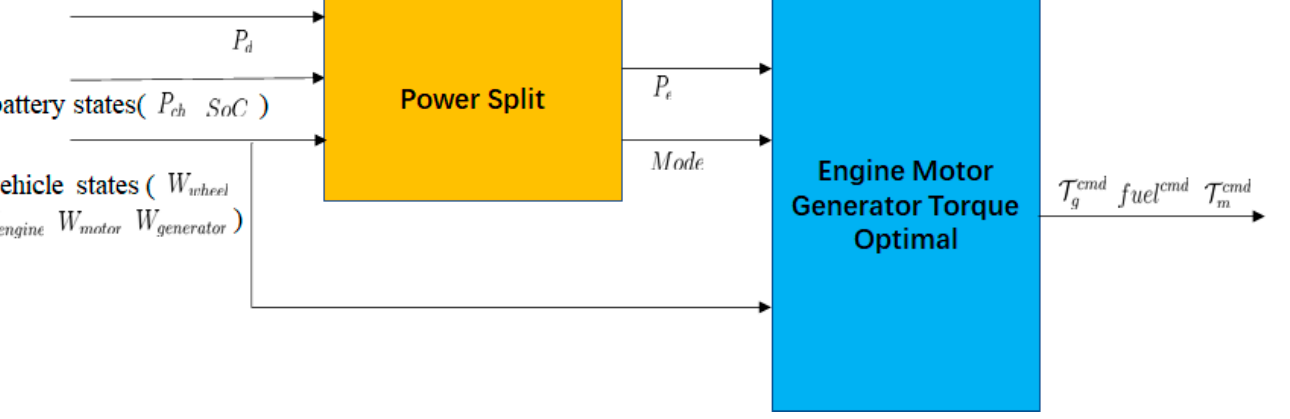
Figure 8. Schematic of the Driving control model.